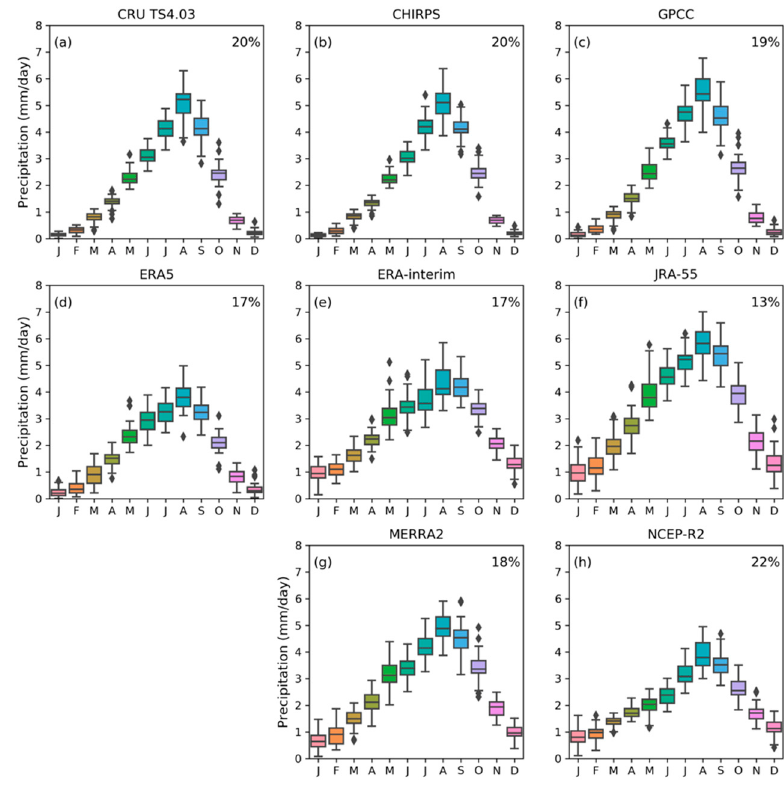
Figure 3. Seasonal cycle with interannual variability of monthly mean precipitation for each dataset over West Africa from 1981 to 2016. Letters on the x-axis represent calendar month. Percentage at the top right depicts the mean relative standard deviation for JJAS. Boxes depict the median within the interquartile range, the whiskers depict the lines that extend to the highest and lowest observations, and the diamonds (outliers) represent values so far removed from other values in the distribution.